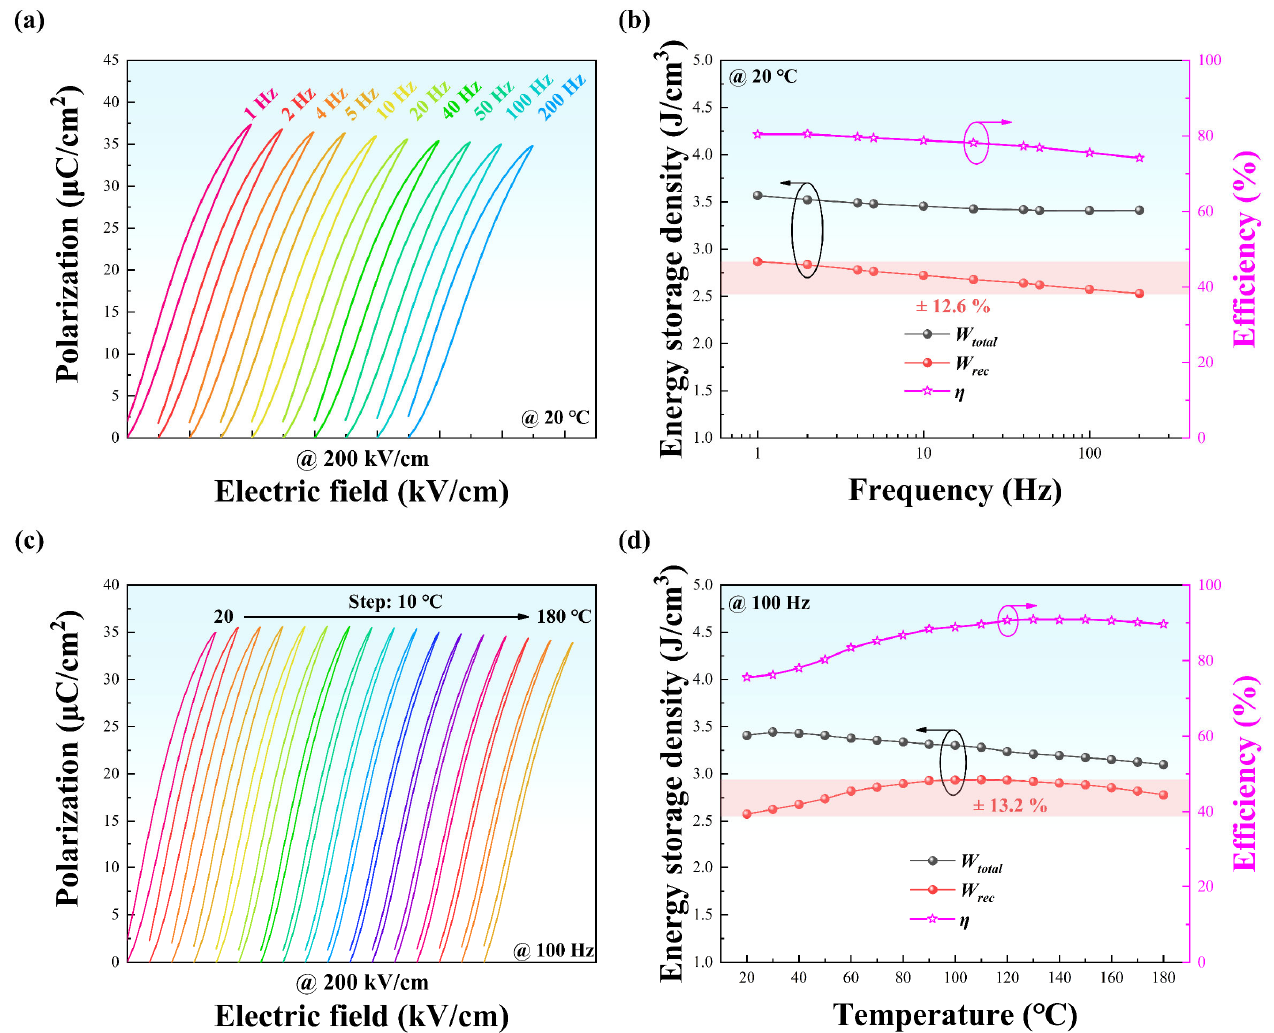
Figure 7. ( a ) Frequency-dependent unipolar P-E loops of x = 0.15 sample at 20 ◦ C under 200 kV/cm in the frequency range of 1–200 Hz; ( b ) the corresponding ESP of ( a ); ( c ) temperature-dependent unipolar P-E loops of x = 0.15 sample at 100 Hz under 200 kV/cm in the temperature range of 20–180 ◦ C; ( d ) the corresponding ESP of ( c ).